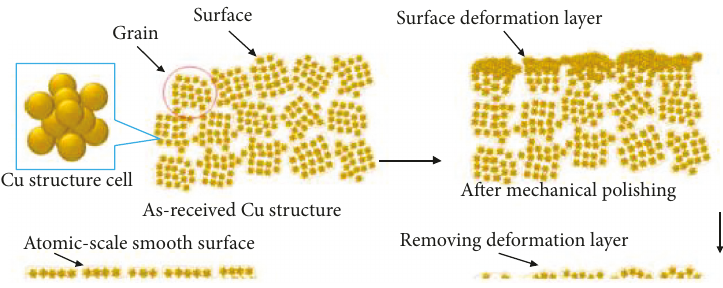
Figure 23: Schematic diagram of preparation of the ultrasmooth surface of Cu